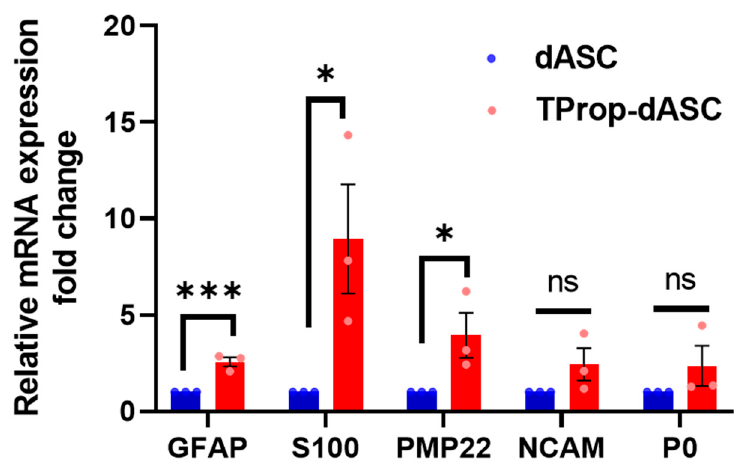
Figure 4. Transcript analysis of Schwann cell differentiation in ASCs. The RT-qPCR analysis for Schwann cell differentiation markers after 2 days of treatment with 50 µ M TProp treatment (TProp-dASC) in differentiation medium showed significantly higher mRNA levels of GFAP, S100, and PMP22, but not for NCAM and P0. Statistical analysis of the RT-qPCR was carried out using the (2 − ∆∆ Ct ) method, which calculates the relative changes in mRNA levels normalized to an endogenous reference (GAPDH) relative to a calibrator (without analog treatment, dASC) that serves as the control group; the differences between treated and control samples were expressed as fold changes. * p < 0.05, *** p < 0.001 ( n = 3, mean ± SEM; Student’s t -test; ns, no significant